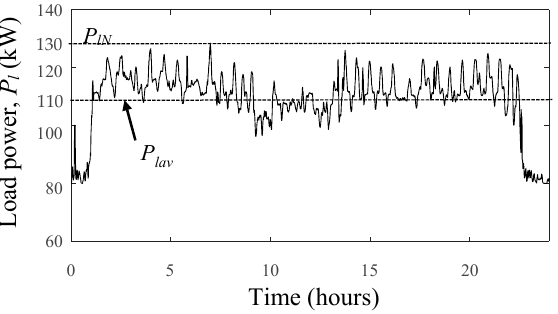
Figure 9. Typical daily power consumption of the consumer.